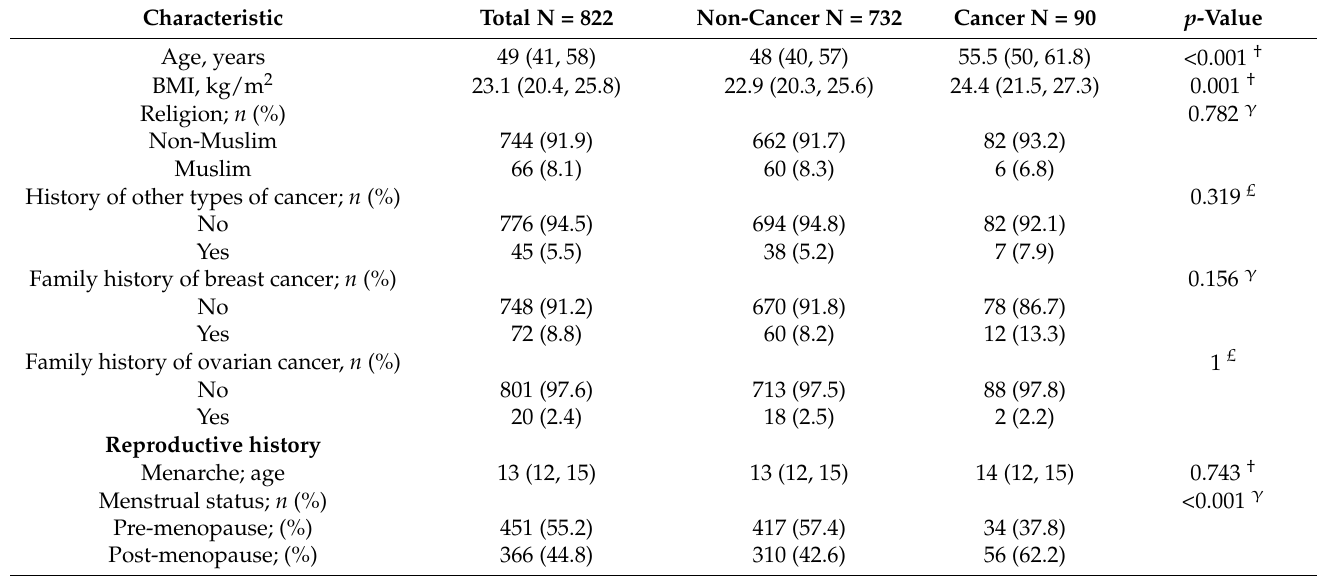
Table 2. Baseline characteristics and demographic data of the analyzed dataset according to breast cancer